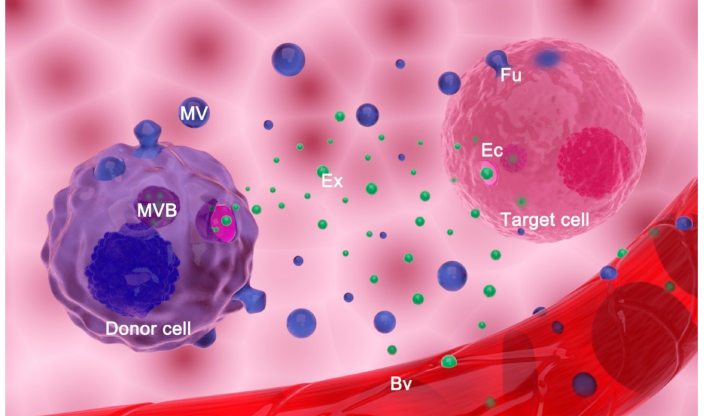
Figure 1. Extracellular vesicles (EVs) release and transfer. EVs comprise exosomes (Exs), microvesi- cles (MVs), and apoptotic bodies (not shown). Exs are released from a donor cell upon fusion of a multivesicular body (MVB) with the plasma membrane. Microvesicles (MVs) are formed by budding of the originating cell’s plasma membrane. EVs reach target cells of the same tissue or they are transferred by body fluids to distant cells (i.e., EVs enter blood vessels (Bv) and are transferred by blood to distant organs/tissues/cells). EVs may deliver information to the target cell by (a) fusion (Fu) with its plasma membrane; (b) endocytosis (Ec) of EVs by target cells; or (c) interaction of surface molecules on EVs and the cell (not